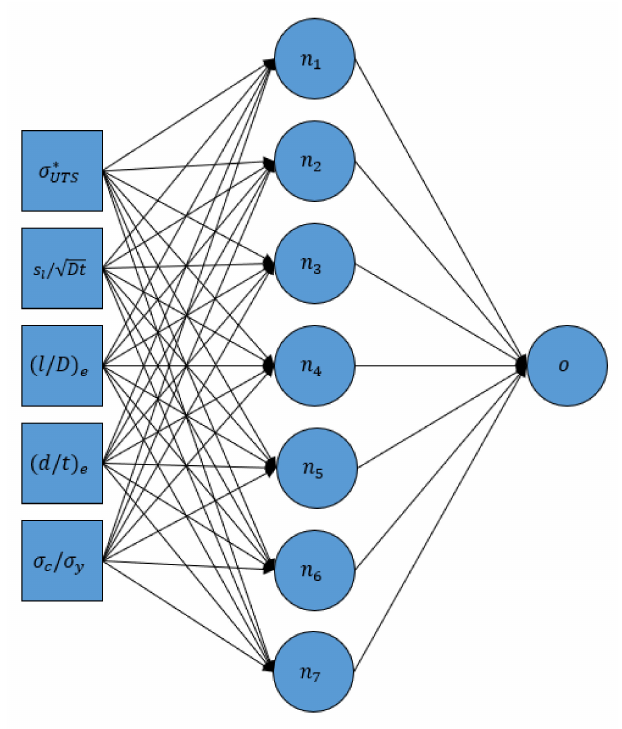
Figure 5. Architecture of the developed